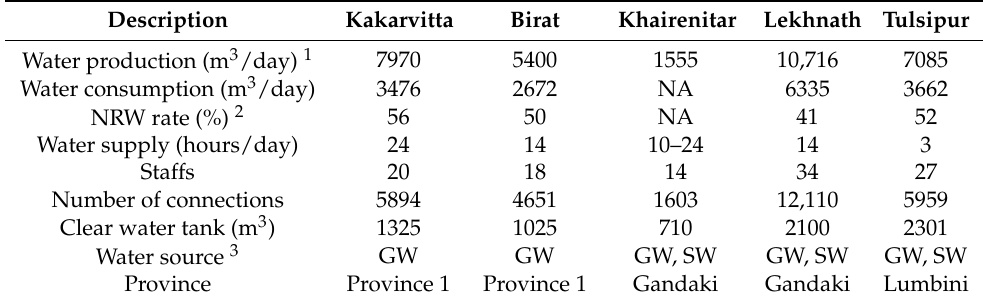
Table 4. Data profile of WUSAs (as per field survey in February–March 2020).